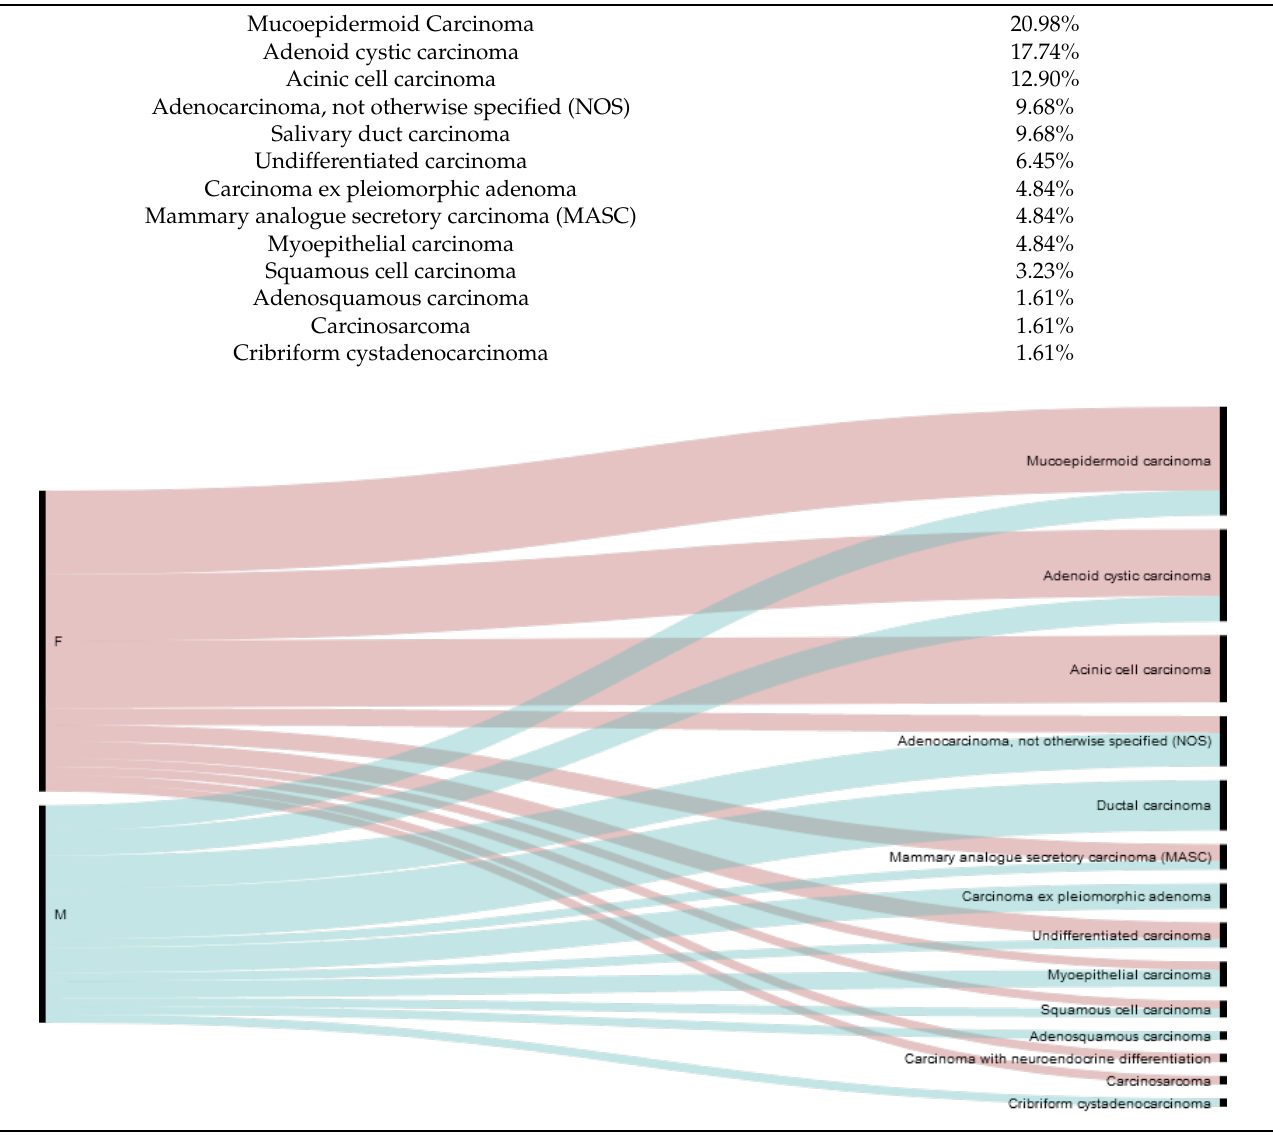
Table 1. Histological subtypes (top panel) and the gender distribution of the histological subtypes (bottom panel) of the study cohort.